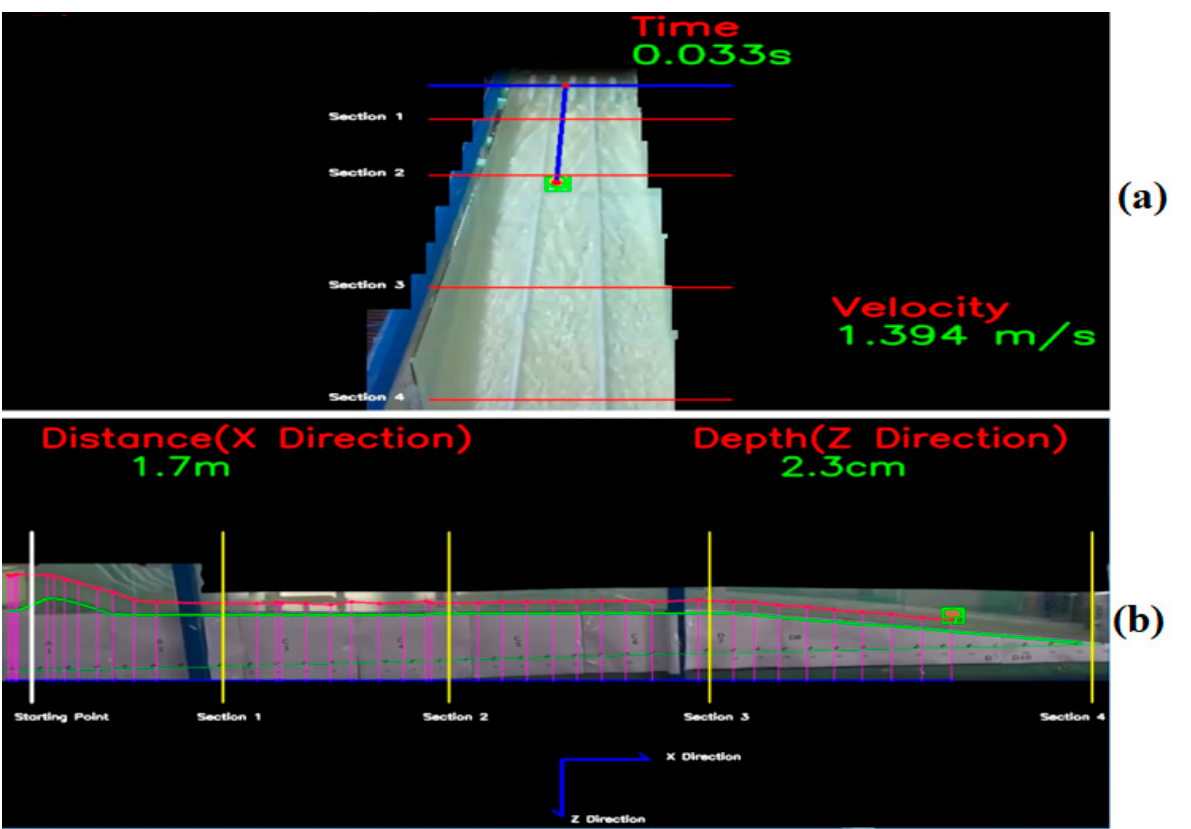
Figure 12. The OpenCV code screens: ( a ) Cam 2, image velocity algorithm; ( b ) Cam 1, image water depth algorithm (Yellow lines show cross-section locations, the green line is the base of the spillway model, and the purple line is the buoyancy trajectory).